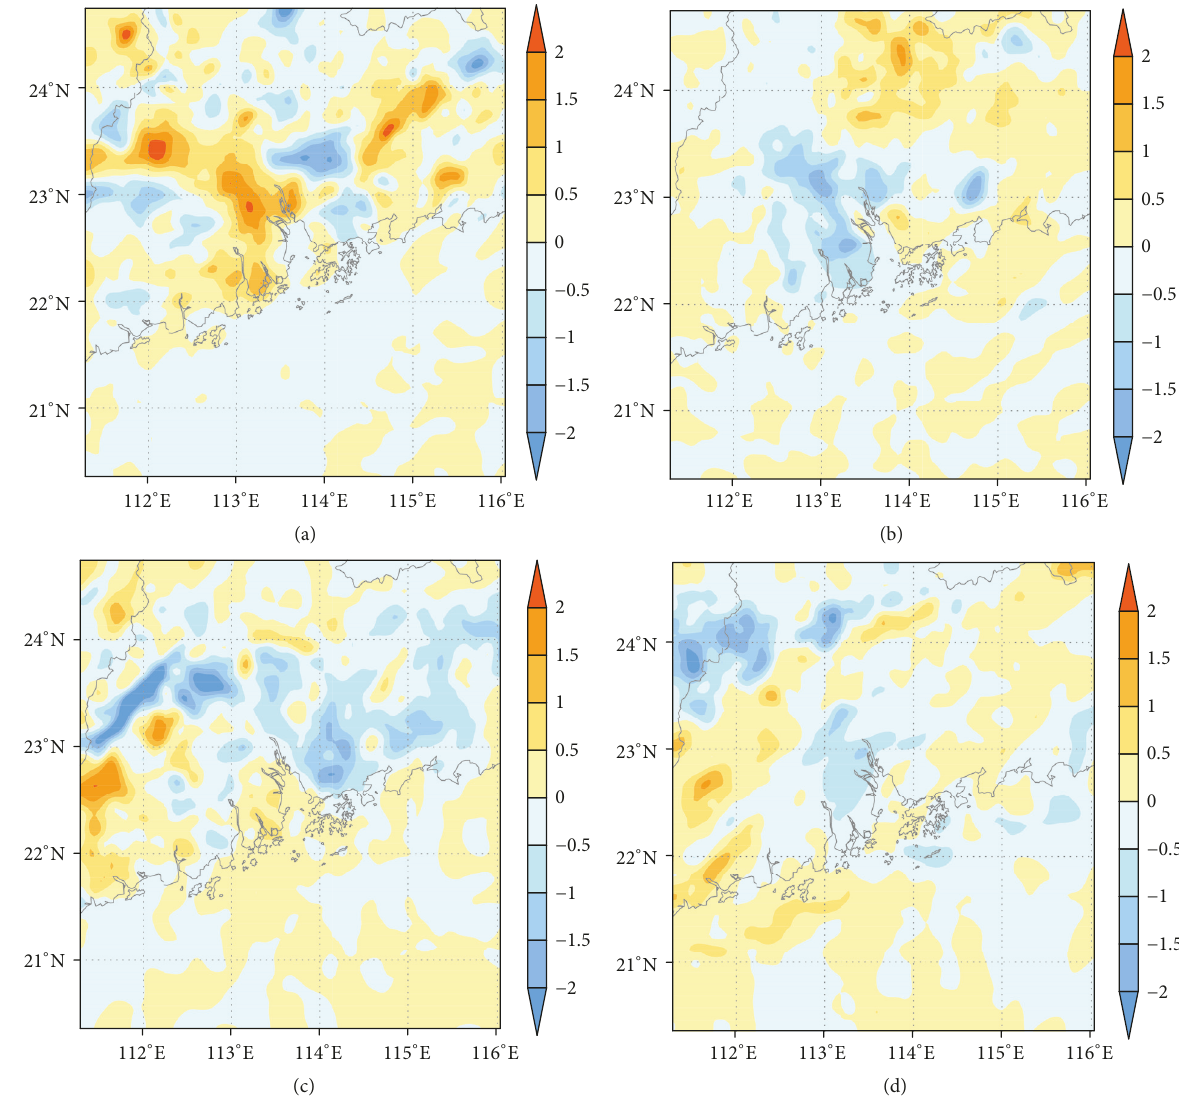
Figure 5: As in Figure 3, but for 2-m temperature. Unit is ∘